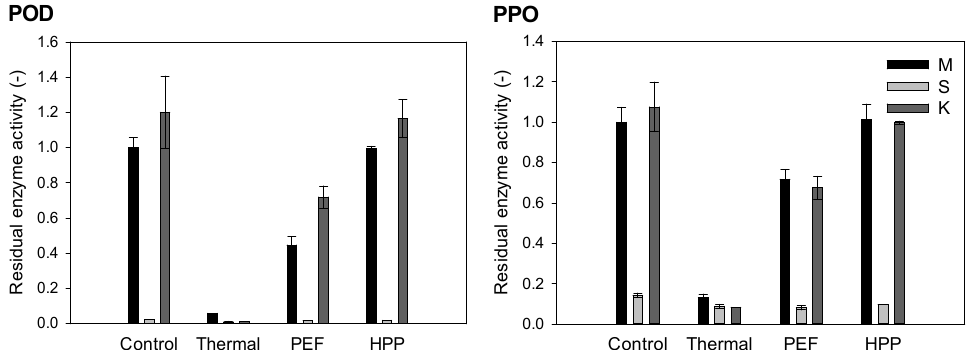
Figure 3. Residual enzyme activity of POD and PPO in the strawberry-kale mix (M), strawberry-water mix (S) and kale-water mix (K) (compared to the untreated strawberry-kale mix) after processing.